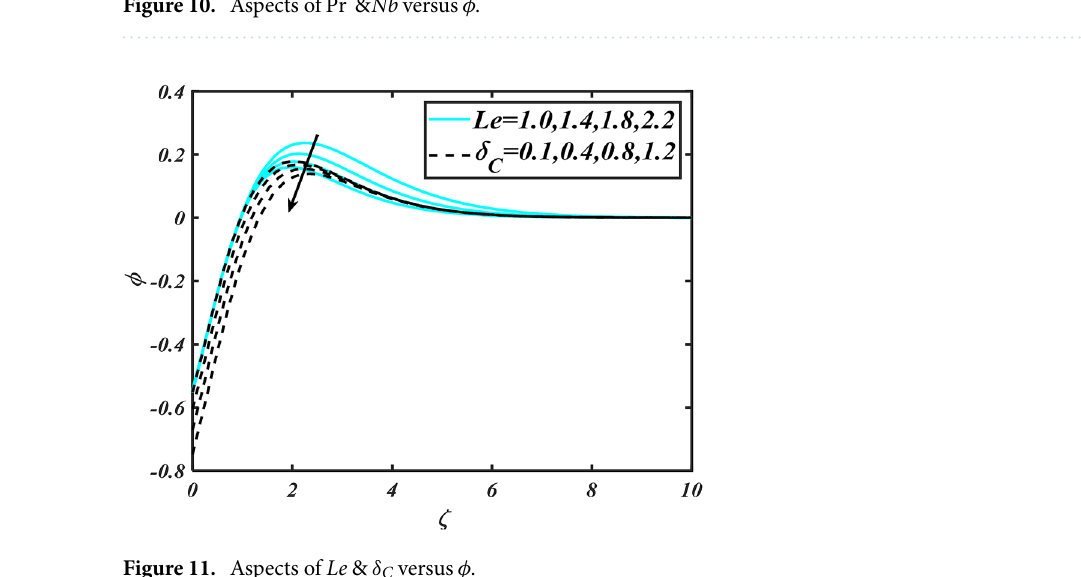
Figure 11. Aspects of Le & δ C versus φ .